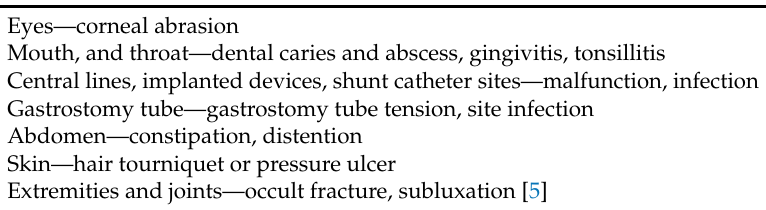
Table 3. Examination for nociceptive causes of pain in children with